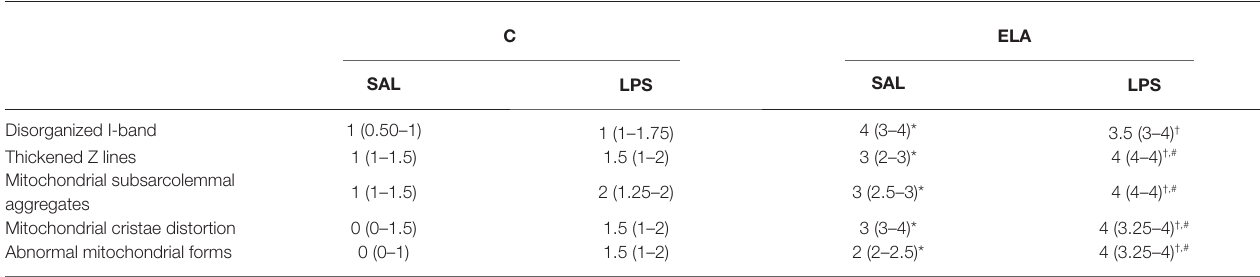
TABLE 4 | Semiquantitative analysis of diaphragm electron